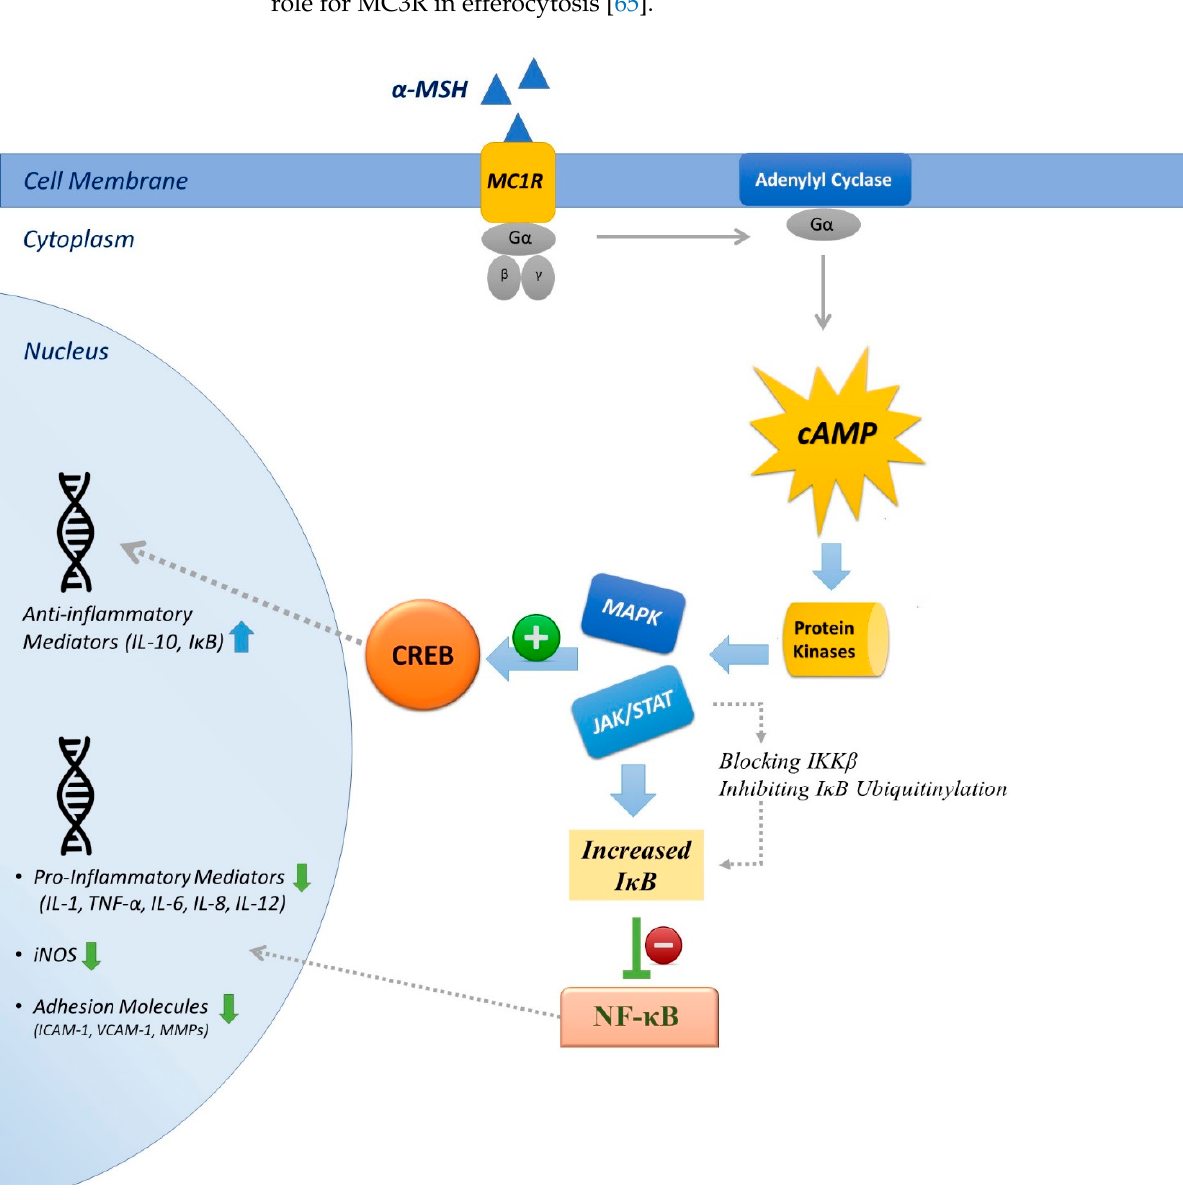
Figure 1. Simplified role of MC1R signaling in anti-inflammatory actions of α -MSH. MC1R activates adenylyl cyclase and generates intracellular cAMP, which activates protein kinases (C and A). This leads to activation of MAPK and JAK and STAT pathways. In the nucleus, the catalytic subunits can phosphorylate different substrates, the best known of which is the transcription factor CREB. CREB is involved in transcription of anti-inflammatory mediators. Alternatively, protein kinase activation can lead to increased cytoplasmic inhibitor of κ B (I κ B) through blocking I κ B kinase, inhibition of I κ B ubiquitinylation, etc. This leads to inhibition of NF- κ B and decreased expression of downstream proinflammatory genes.